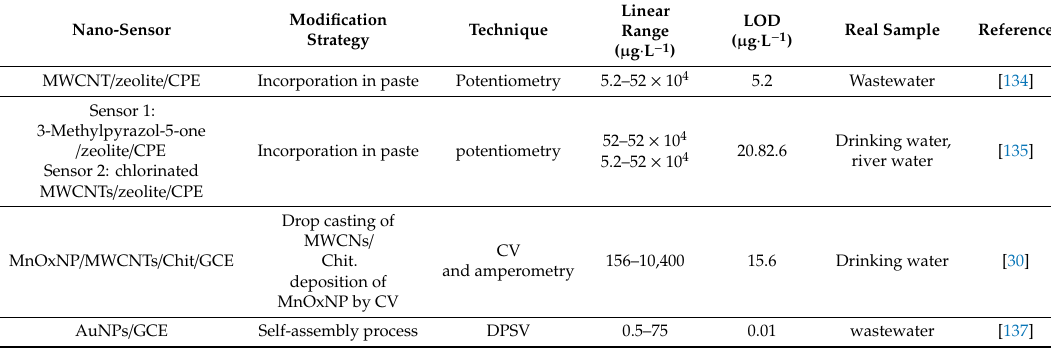
Table 6. Summary of the electroanalytical data of reported electrochemical sensors and biosensors for trivalent chromium